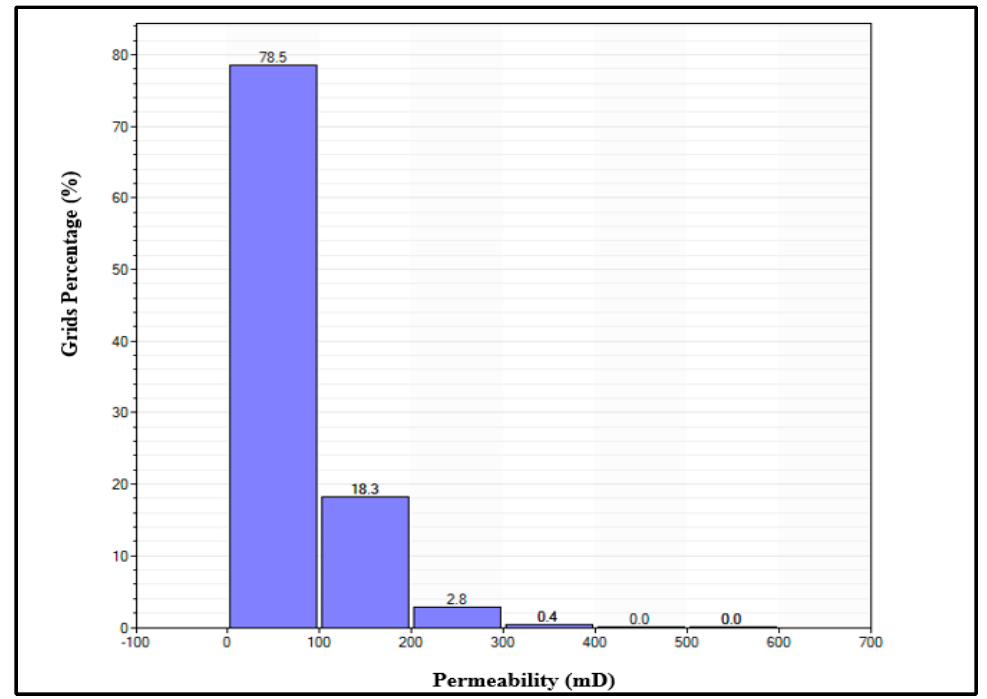
Figure 16. Horizontal permeability distribution for the N Field sector reservoir model.